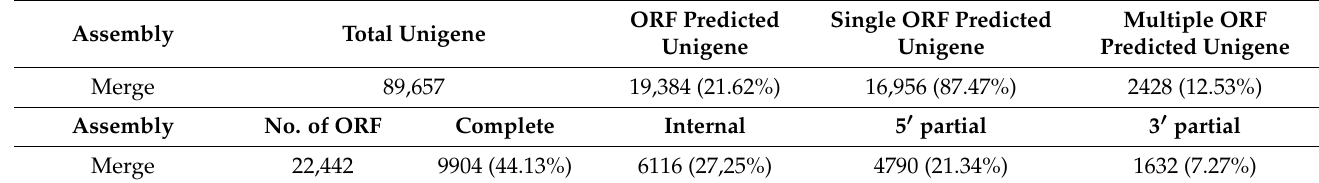
Table 2. Statistics of Open Reading Frame (ORF) prediction.